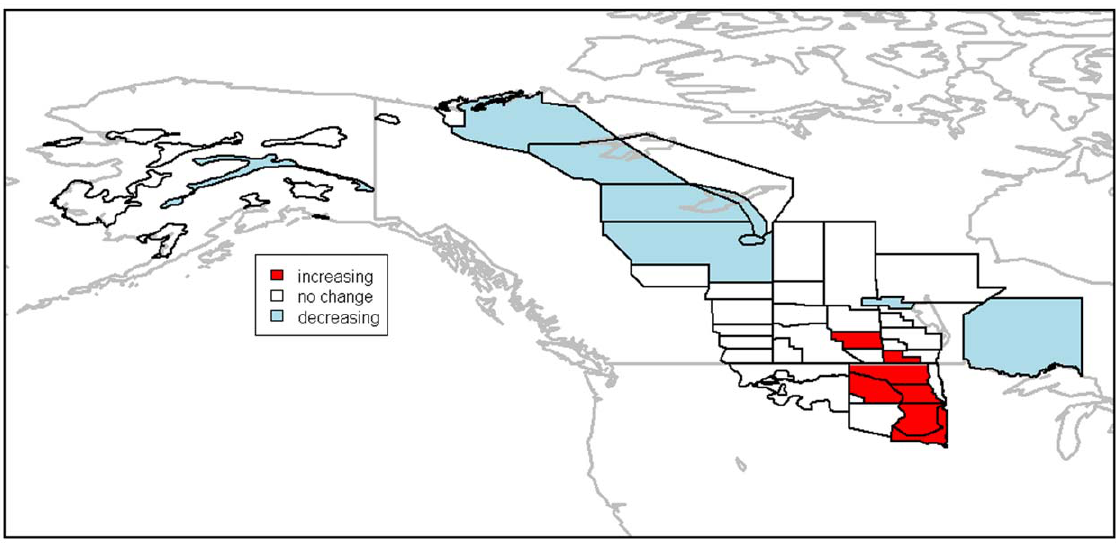
Figure 3. Increases and decreases in the abundance of breeding pairs since 1957 based on posterior distributions for the b 1, j coefficients. Highlighted areas show an 95% chance of the population increasing (red) or decreasing (blue) in the area since